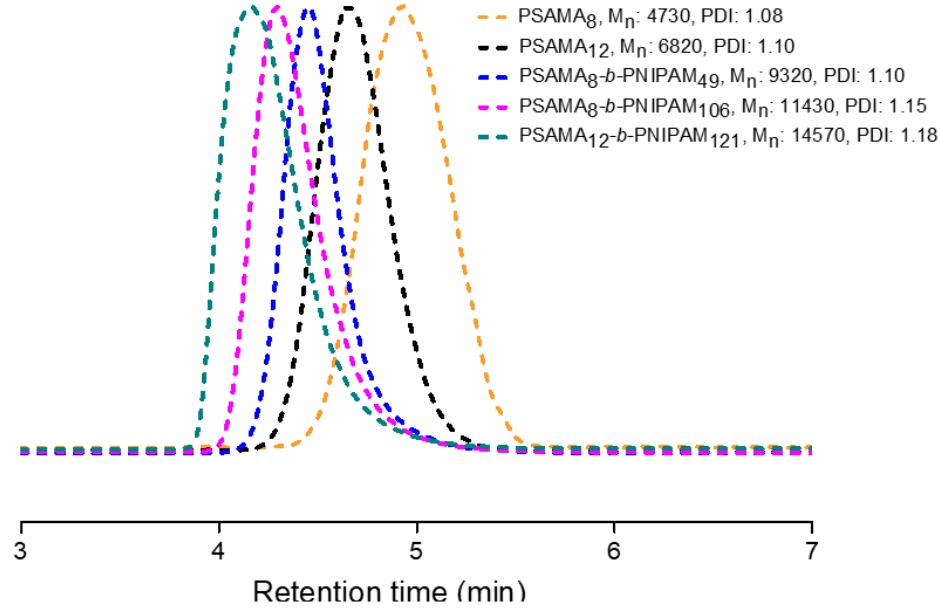
Figure 2. GPC traces of block copolymer PSAMA- b -PNIPAM and its PSAMA macro-CTA. The structural differences of monomer, homopolymers and block copolymer were also studied by FTIR. As illustrated in Figure 3, in the IR spectrum of the SAMA monomer, the peak for C=C was observed at 1645 cm ⁻ 1 . The peaks at 1724 and 1742 cm ⁻ 1 corre- sponded to the two ester carbonyl groups’ stretching. It was found that after polymeriza- tion, C=C double-bond peak disappeared and there was a broad C=O peak at 1735 cm ⁻ 1 in the spectrum of PSAMA. In the spectrum of PSAMA- b -PNIPAM, all characteristic absorp- tion peaks can be observed associated with both blocks. For example, it includes stretching vibration of ester carbonyl group in PSAMA at 1735 cm ⁻ 1 and secondary amide C=O stretching at 1652 cm ⁻ 1 , amide N–H bending at 1541 cm ⁻ 1 as well as N–H stretching at 3200–3400 cm ⁻ 1 , which belong to PNIPAM. In conclusion, FTIR spectra also supported the successful preparation of the block copolymer.